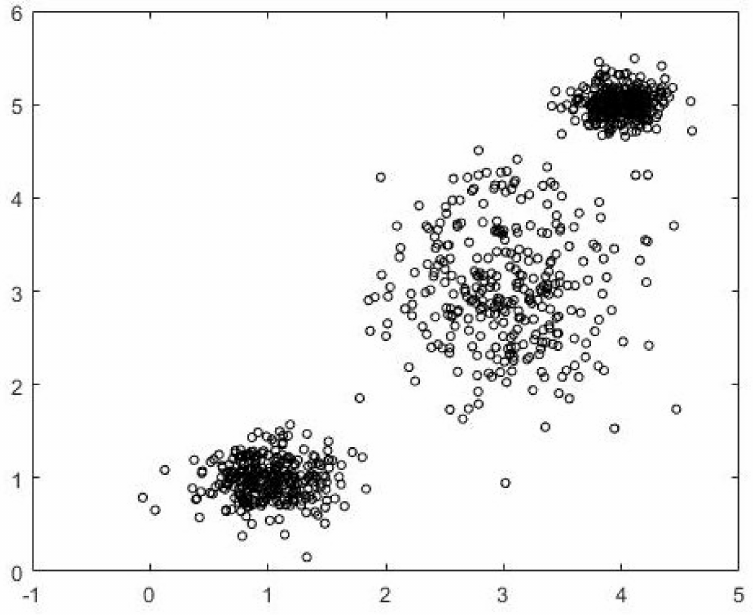
Figure 2. Data1 ( n = 900, c = 3, H =